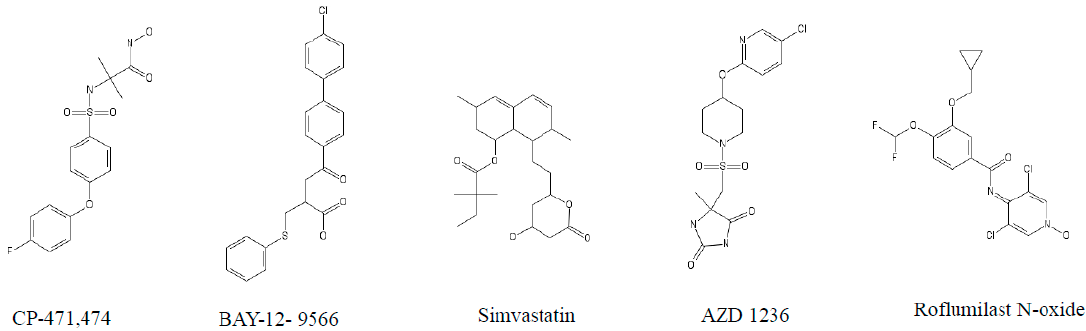
Figure 3. Structure of different matrix metalloprotease inhibitors tested against COPD models.